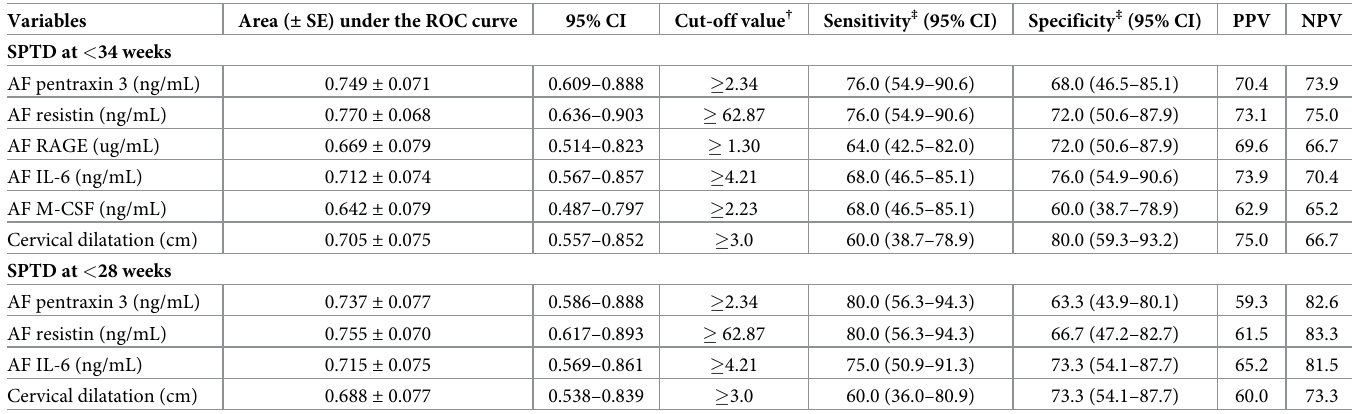
Table 4. Diagnostic indices of various amniotic fluid proteins and clinical factors to predict spontaneous preterm delivery (SPTD) after cerclage placement.